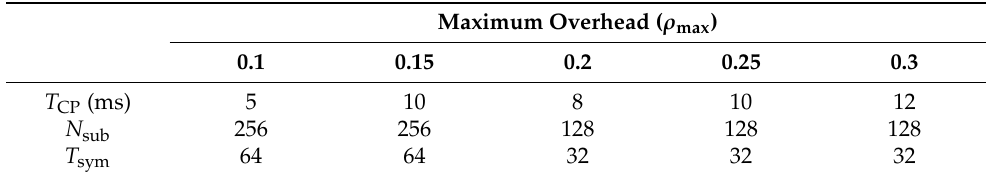
Table 4. Optimized parameters for BCH1 channel.